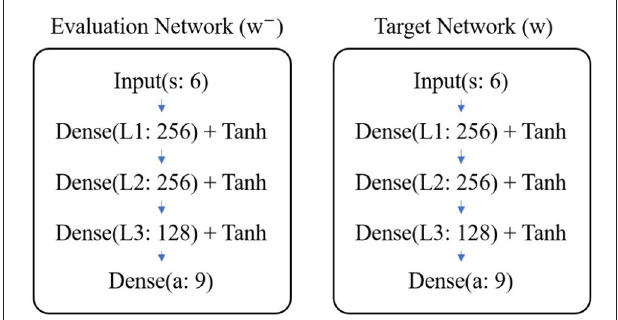
FIGURE 6 | Structure of DQN.